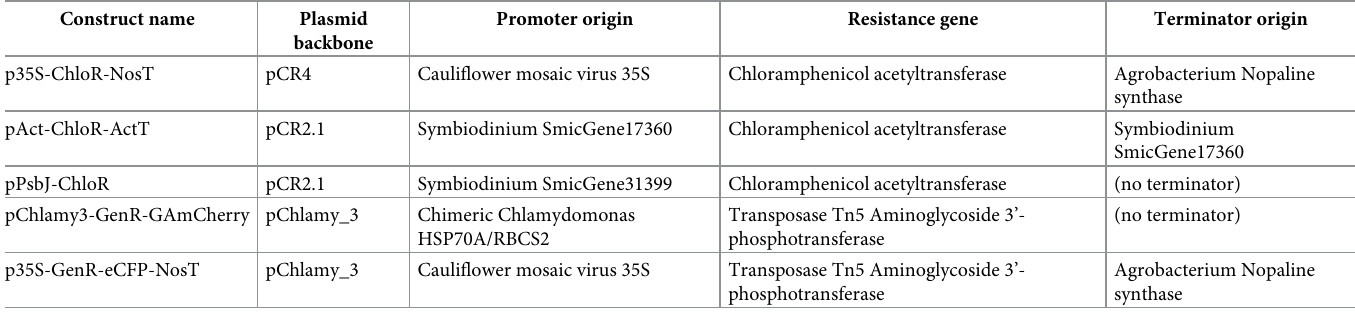
Table 3. List of constructs used for CS-153 transformation using silicon carbide whiskers. Construct